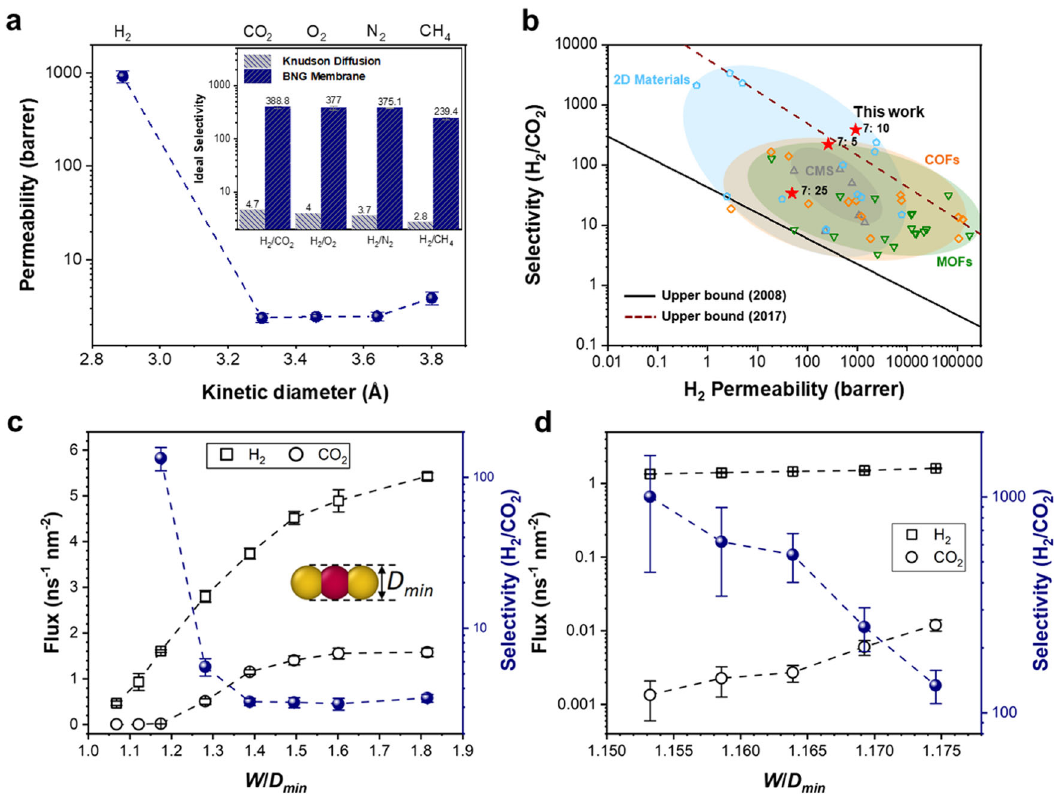
Fig.4|Gasseparationperformanceandmoleculardynamicssimulationsofthe fabricatedBNG heterostructuredmembrane(FBN:chitosan=7:10).a Singlegas permeability of the BNG membrane as a function of the gas kinetic diameter at 25°C. The inset represents the ideal selectivity of hydrogen to other gases. b The H 2 /CO 2 separation performance of our BNG membranes compared with other molecular sieving membranes. The black line indicates the 2008 Robeson upper boundof polymericmembranes 6 ,andtheburgundydashed lineindicatesthe2017